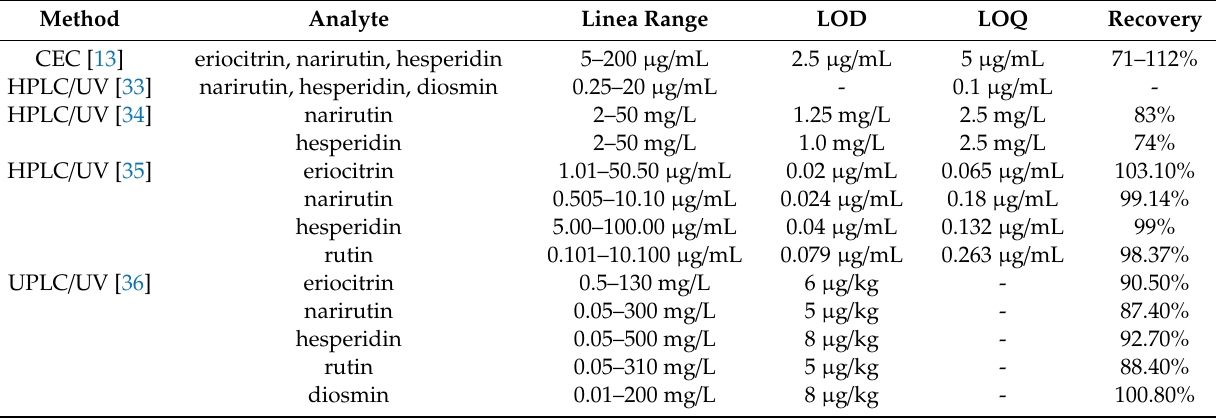
Table 4. Comparison of analytical methods reported for determination of flavonoid glycosides in